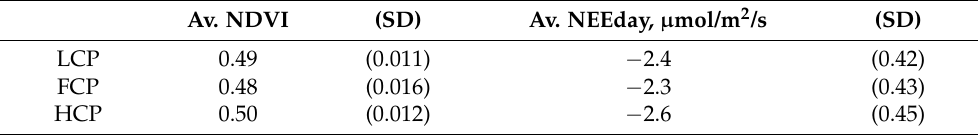
Table 2. Spatial average of NEE and NDVI temporally averaged (Av.) over the growing season in each polygon type, and the spatial average of peak NEE and NDVI in each polygon type. Av. NDVI (SD) Av. NEEday, µ mol/m 2 /s